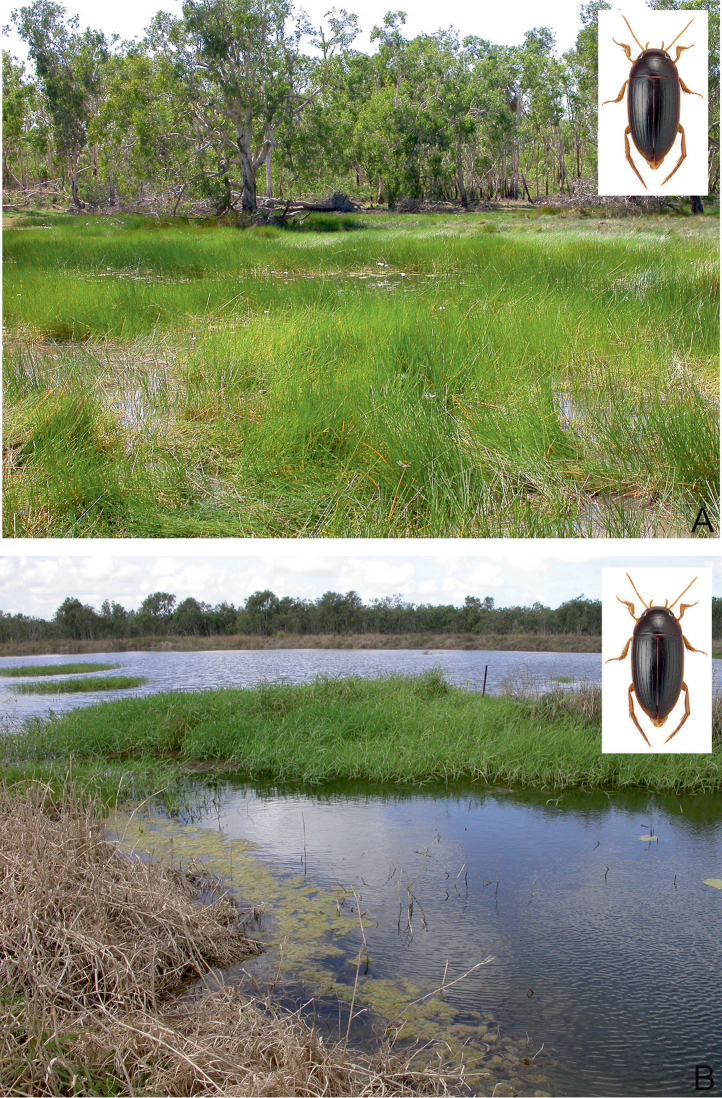
Habitat of Copelatus
tenebrosusA Northern Territory, Georgetown Billabong, 750 m east of Jabiru East, 30 m, beetles were in very shallow water among the sedges B Queensland, 10 km south of Mizani, Lake Kinchant, beetles were in shallow water among mats of floating grasses, 48 m. Photographs by L. Hendrich.